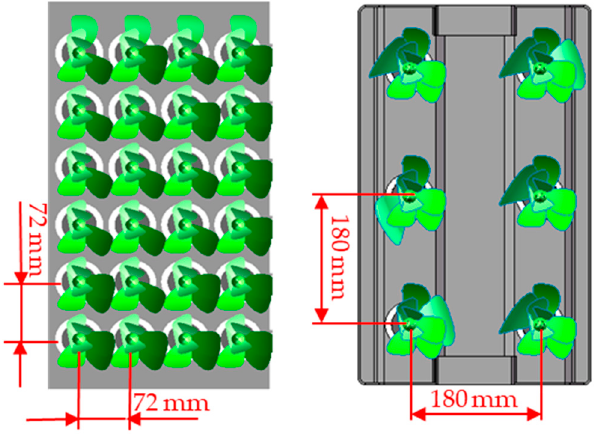
Figure 12. A seedling tray and a transplanting plate.